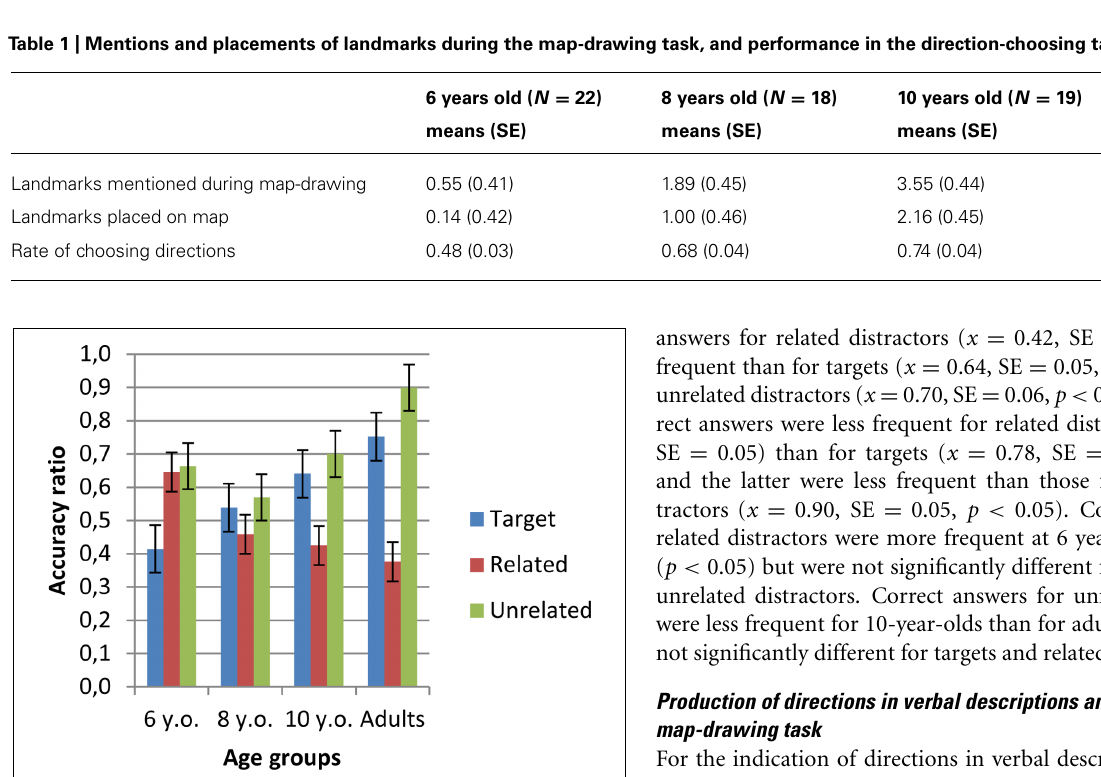
well as an interaction between these two factors [ F (6,150) = 7.03, p < 0.0001, η 2 = 0.22]. Correct recognition of targets and cor- rect rejects of unrelated distractors increased with age. In contrast, correct rejects of related distractors decreased with age. Post hoc analyzes showed different performance profiles at each age. At 6 years correct answers were less frequent for targets ( x = 0.44,